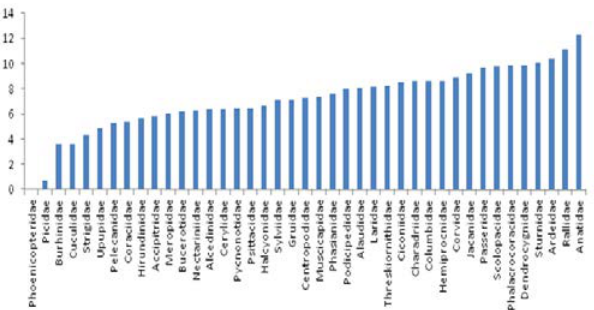
Fig. 2. Wetlands birds (by family) across managed wetlands of UP represented by numbers (in natural log scale) in different families. Around 60% birds are from top three families of aquatic birds, eg. Anatidae, Rallidae, and